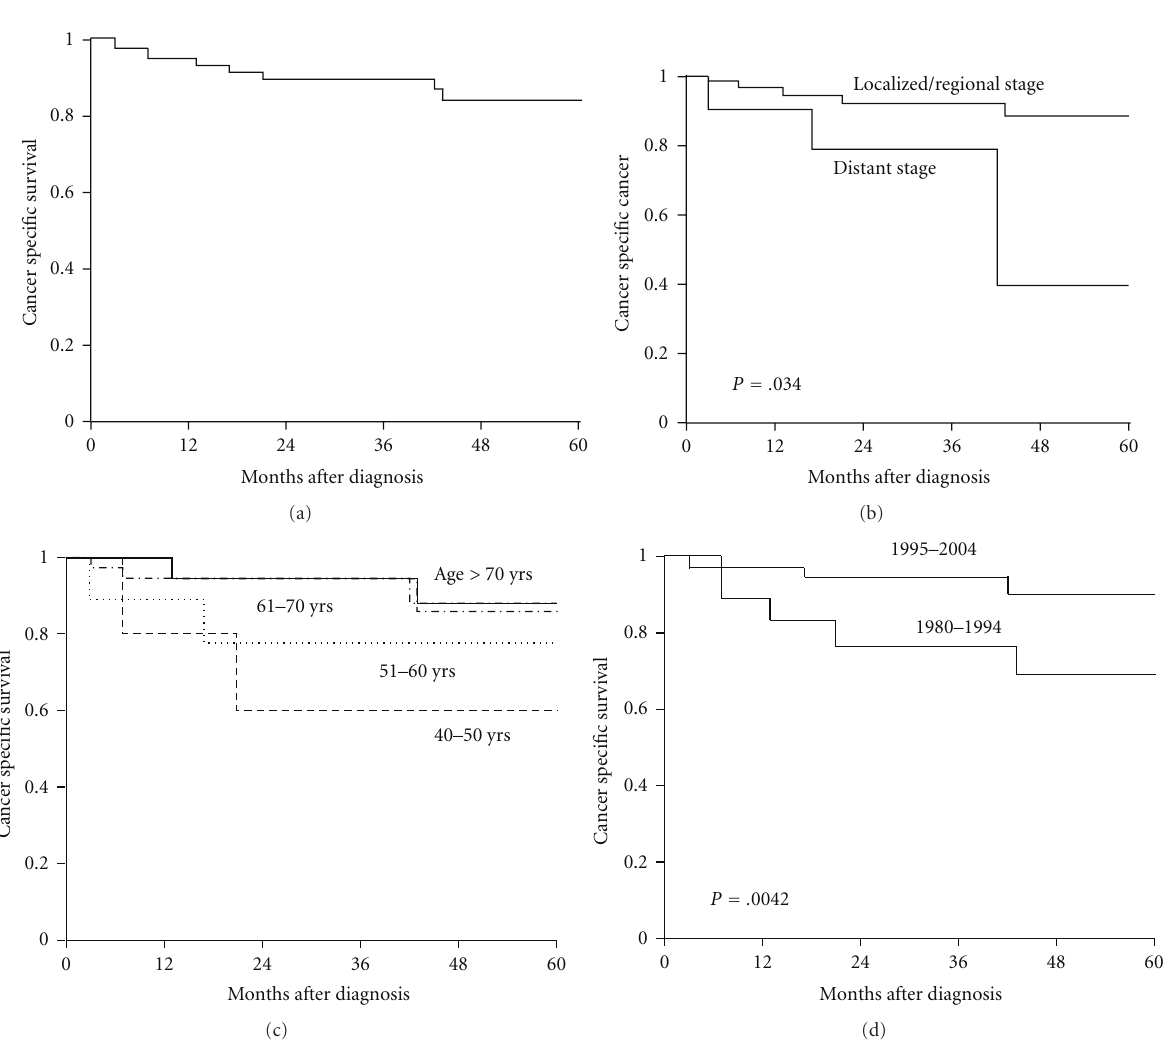
Figure 1: Kaplan-Meier survival curves for (a) cancer-specific survival of entire cohort, (b) cancer-specific survival by subgroups of di ff erent tumor stages, (c) cancer-specific survival by age subgroups, and (d) cancer-specific survival rate of patients by subgroups of di ff erent diagnosis year. P -value shown for log-rank test between two